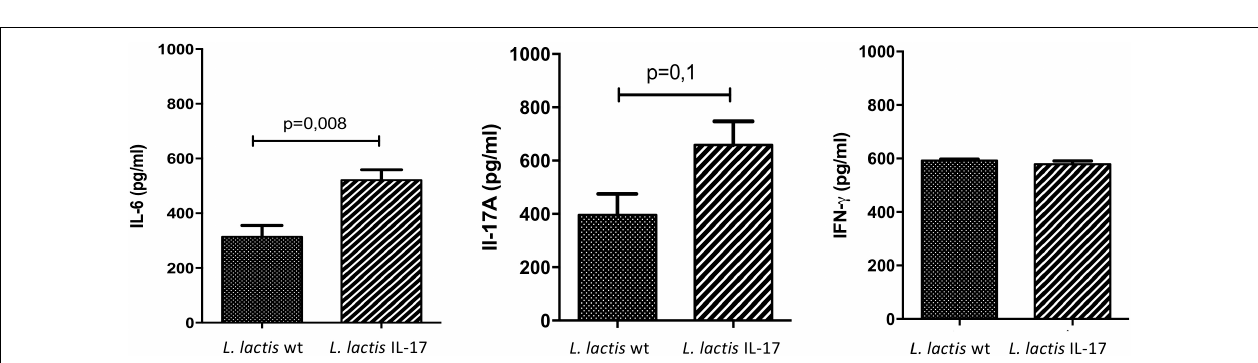
FIGURE 3 | Effect of recombinant L. lactis expressing IL-17 against tumors in TC-1 allograft model of HPV-induced cancer. Mice were i.n. treated with 1 × 10 9 CFU resuspended in 10 µ l of PBS (5 µ l were administered with a micropipette into each nostril) on D-35, -21, and -7. Seven days after the last administration (D0), a challenge with the tumoral cell line TC-1 was performed, and the presence and size of the tumor was monitored once a week. (A) Tumor incidence with proportions of tumor-free animals (B) Individual tumor volume at the end of week 10. Data represented mean ± SEM from 3 independent in vivo experiments.